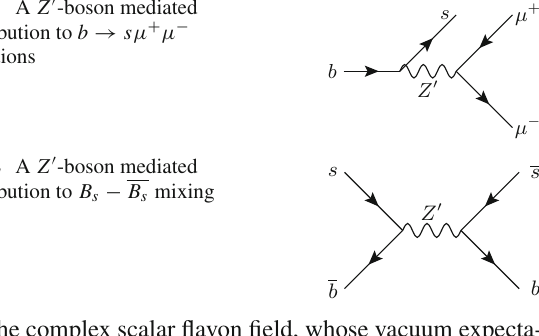
ables [1]. The three gauge boson mass eigenstates that result are the (massless) photon, the Z 0 boson of mass M Z and the Z (cid:2) boson of mass M Z (cid:2) . The two non-zero gauge boson masses are